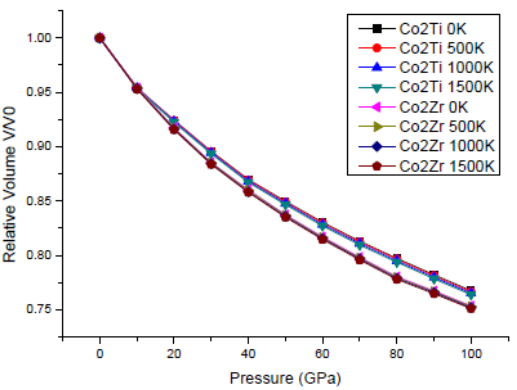
Figure 2. The V/V 0 of Co 2 Zr and Co 2 Ti versus pressure from 0 to 100 GPa at 0, 500, 1000 and 1500 K.